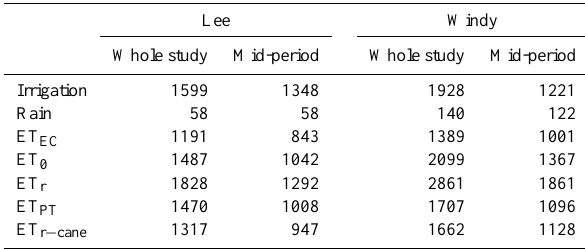
Table 2. A summary of cumulative irrigation, rain, actual measured evapotranspiration-ET EC , and reference evapotranspiration values (ASCE short-ET 0 and tall-ET r , Priestley–Taylor ET PT , and a cus- tom cane reference ET-ET r − cane ) for the entire study period and the mid-period. All values are in mm. Lee Windy Whole study Mid-period Whole study